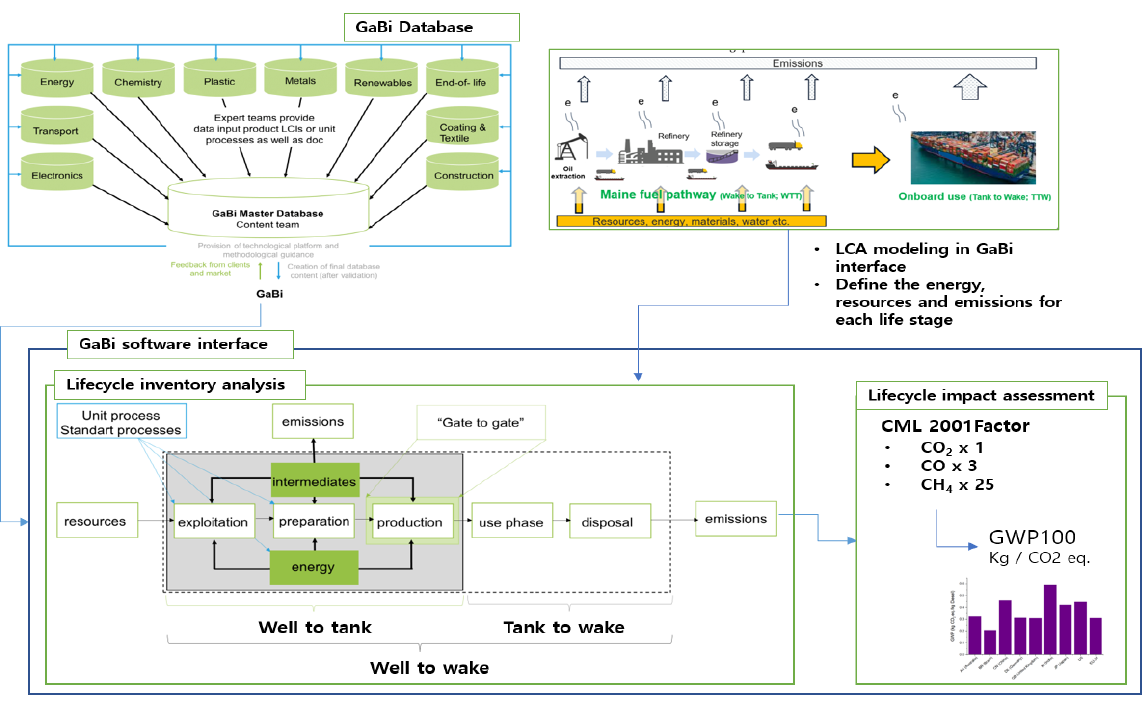
Figure 20. The overall LCA process using GaBi Software; e means emission.